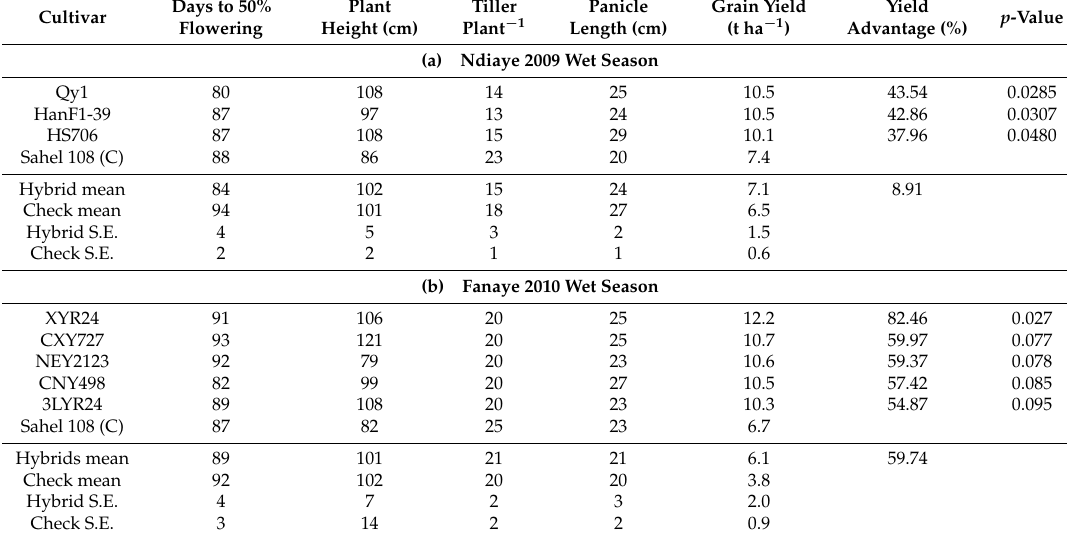
Table 2. Grain yield and other agronomic traits of promising rice hybrids and best cultivar check (C)